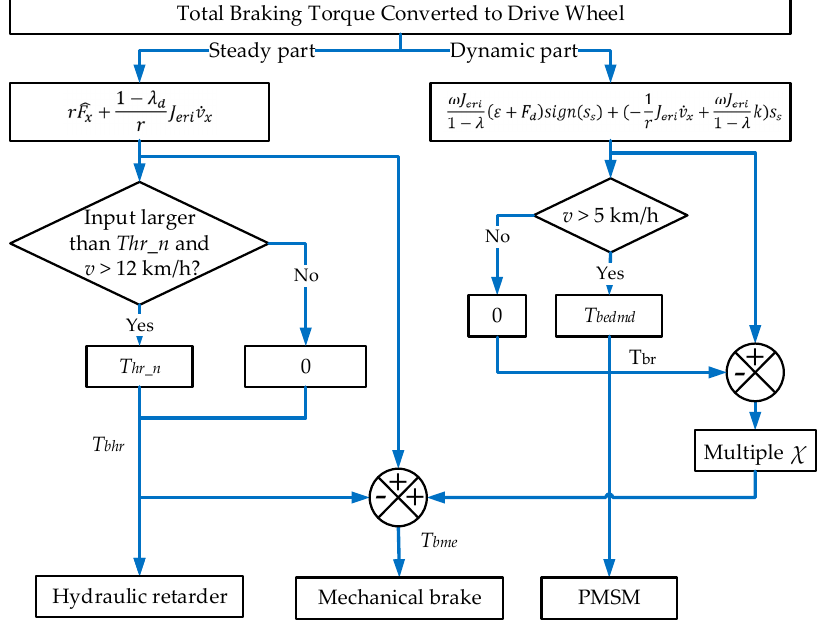
Figure 5. Schematic diagram of the braking torque allocation method.